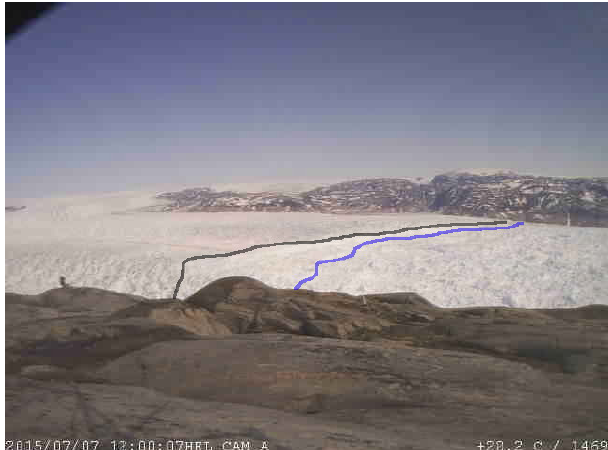
Figure 8. Local camera imagery for the calving event from 7 July 2015. The blue line indicates the calving front from the last image taken before the calving event, and the black line indicates the first image taken after the calving events. Images are taken ev- ery hour. The position of the camera is given in Fig. 1